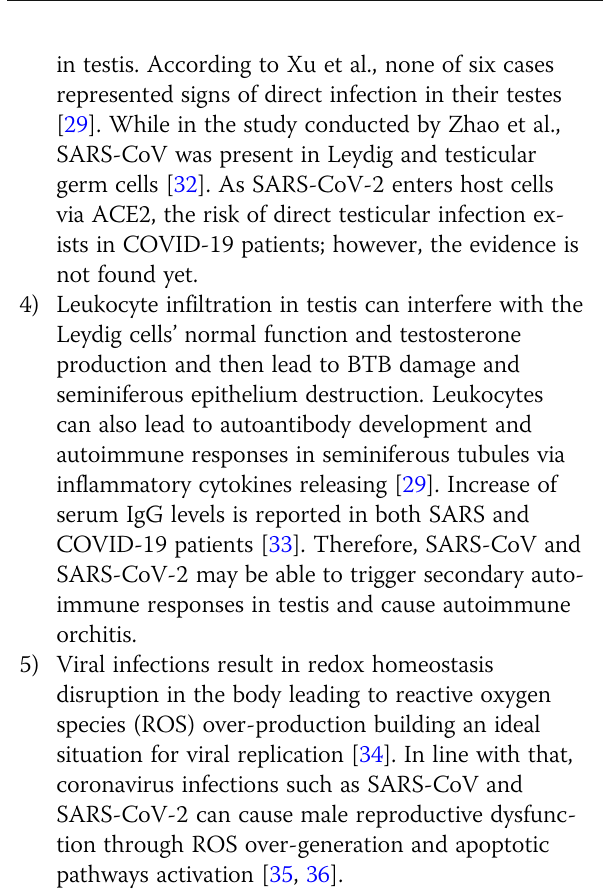
Fig. 2. Possible mechanisms of COVID-19-induced testicular